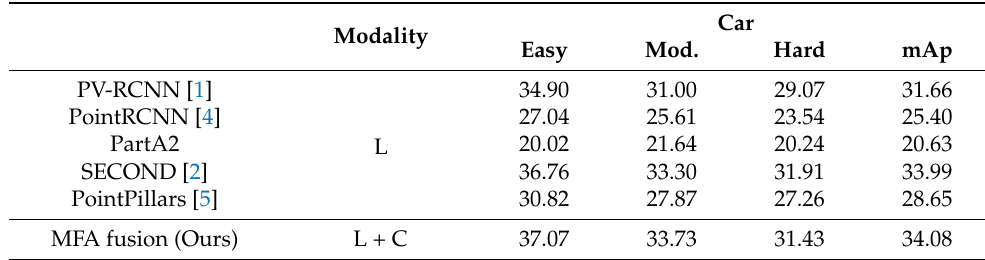
Table 3. Results of 3D detection on the KITTI val split with rain noise before training for the Car category.